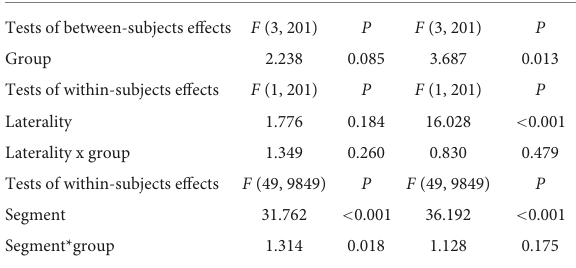
TABLE 2 Three-way mixed design analysis of covariance (ANCOVA) in Superior longitudinal fasciculus in three kinds of psychiatric disorders and healthy